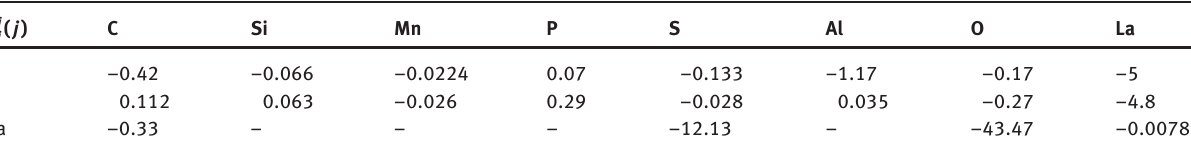
Fig. 1: The Gibbs free energies of formation of some La compounds in liquid iron: (a) the standard Gibbs free energies as a function of temperature; (b) the Gibbs free energies as a function of La content at 1600 °C Table 2: Interaction coefficient of each element in liquid steel at 1600 °C